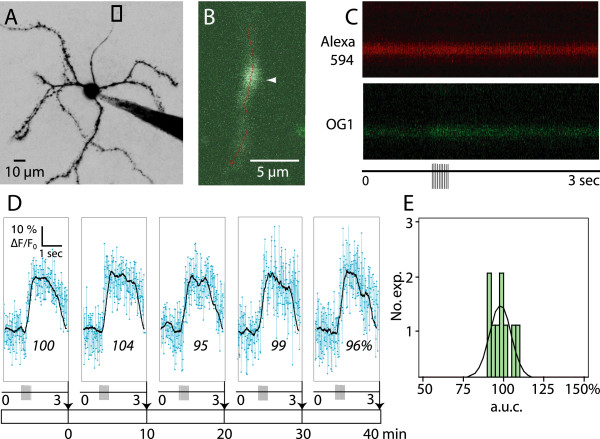
Reproducible Ca2+ responses at individual presynaptic varicosities evoked by brief tetanic stimulation. A. The recorded MSN is shown as a projection image created from a confocal z series of Alexa594 images. The area outlined (black rectangle) corresponds to the area imaged in panel B. B. OG1 fluorescence image showing the stretch of axon contained one hot spot (arrowhead). The spline used is shown in red, superimposed on the OG1 image. C. Spline scan images. Top image shows Alexa594, and bottom OG1. The timing of repetitive depolarizing pulses to evoke 10 action potentials is indicated on the time line (bottom). As compared to the Alexa594 trace, the OG1 trace shows a stimulation-dependent increase in fluorescence intensity, which is shown in the line graphs in the next panel. D. Ca2+ imaging was repeated under control conditions (without drug application) at 10 min intervals, as diagramed on the time line. Raw traces are shown in blue, and smoothed traces (moving average of ten, see Methods) are superimposed in black. The total duration of the experiment was 40 min. The magnitude of the subsequent Ca2+ responses (measured as area under the curve, a.u.c.) expressed as a percent of the initial response is indicated below each trace. The Ca2+ responses varied less than 5%. E. To test reproducibility, Ca2+ responses were evoked twice under control conditions (no drugs) and the a.u.c. of the second response was expressed as the percent of the first response (n = 9). The second response did not differ significantly from the first (see Results).